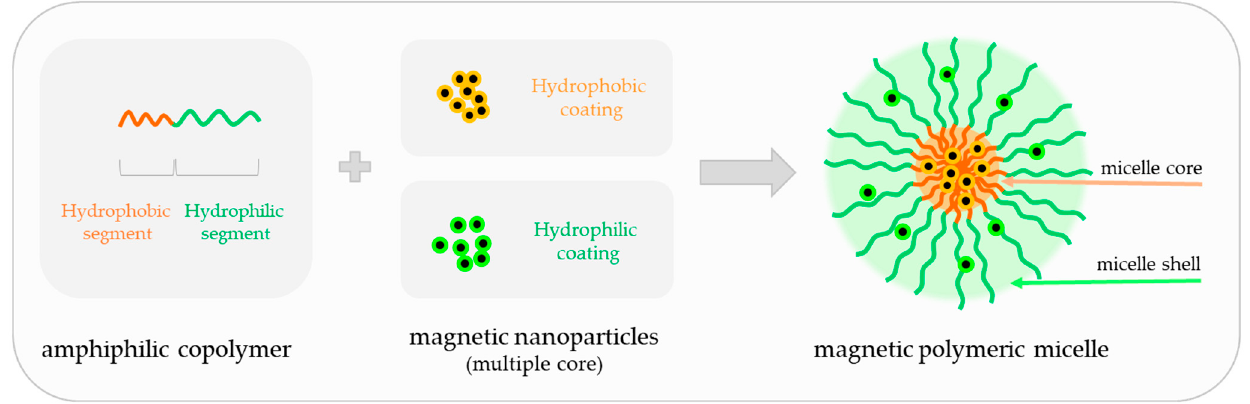
Figure 1. Schematic representation of a magnetic polymeric micelle (MPM). MPMs are formed by self-assembly of amphiphilic copolymers in the presence of multiple magnetic nanoparticle (MNPs) units. MNPs can have a hydrophilic (light green) or hydrophobic (light orange) coating to be incorporated into the hydrophilic (green) or hydrophobic (orange) segment of the polymeric micelle, respectively.